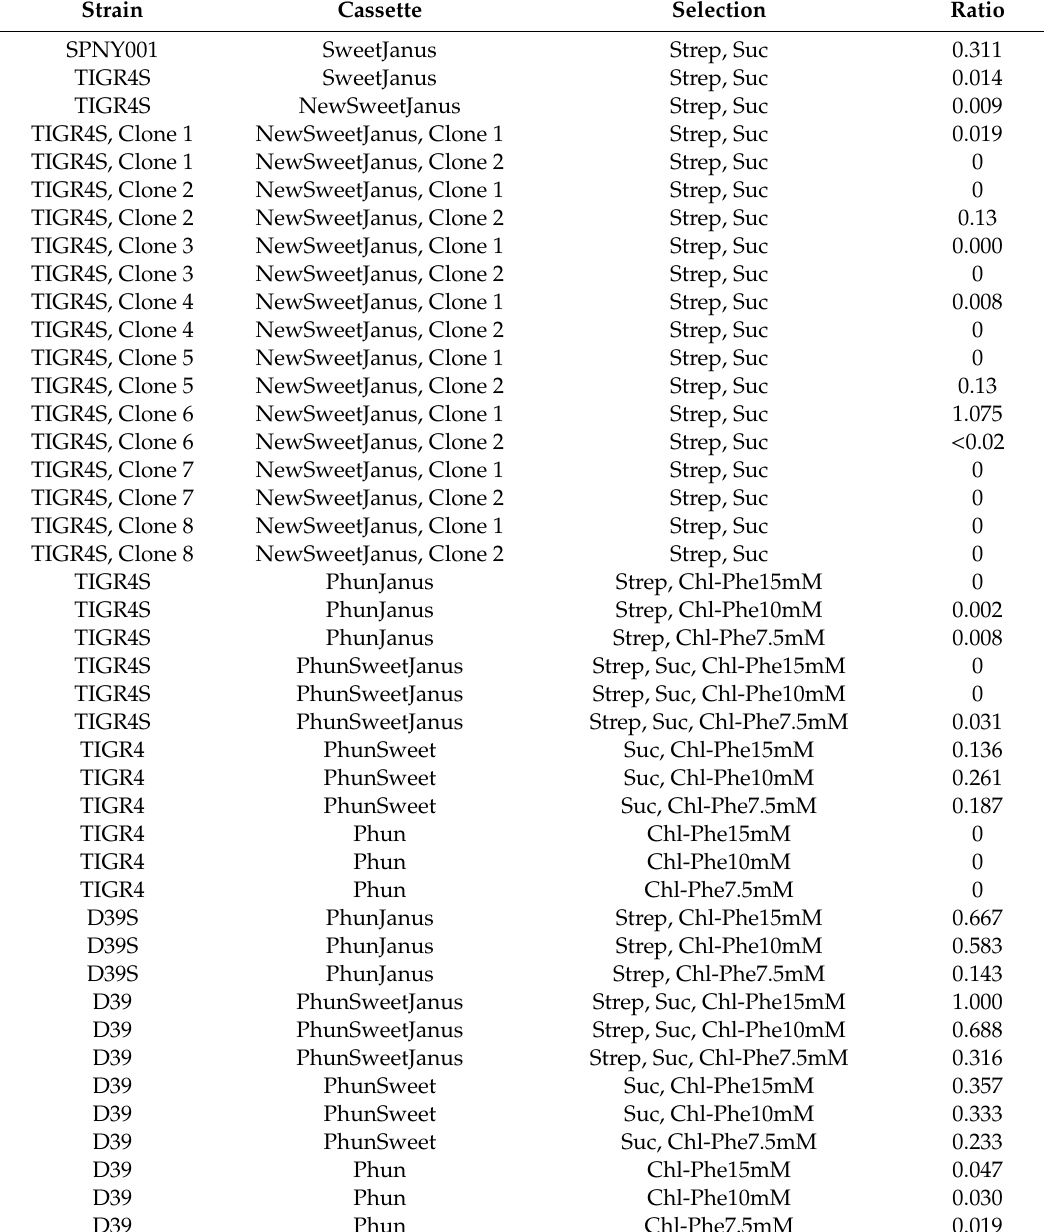
Table 6. Ratio of true positive to false positive colonies. Selection occurred on 800 µ g / mL